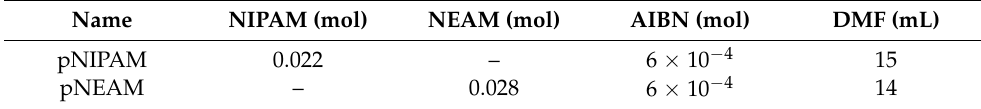
Table 1. Preparation of homopolymers.